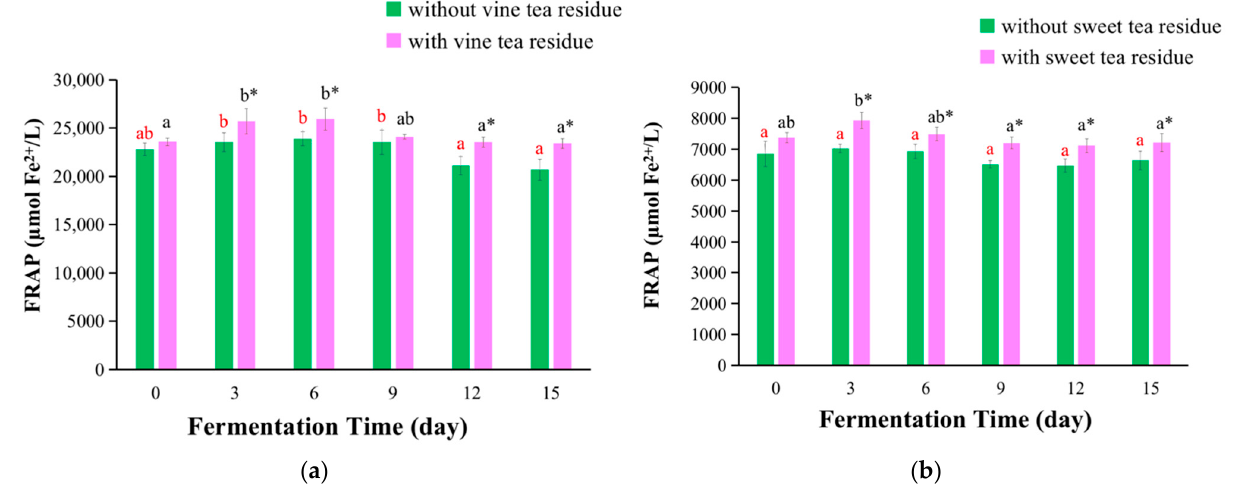
Figure 2 . Changes of FRAP values of kombucha beverages at different fermentation time. ( a ) FRAP values of kombucha from vine tea; ( b ) FRAP values of kombucha from sweet tea. The different red letters indicated that kombucha fermentation without tea residues at different fermentation time were significant differences ( p < 0.05), and the same red letter indicated no significant difference ( p > 0.05). The different black letters indicated that kombucha fermentation with tea residues at different fermentation time had significant differences ( p < 0.05), and the same black letter indicated no significant difference ( p > 0.05). * Indicated that there was a significant difference between the kombucha fermentation with tea residues and kombucha fermentation without tea residues at the same fermentation time ( p < 0.05).